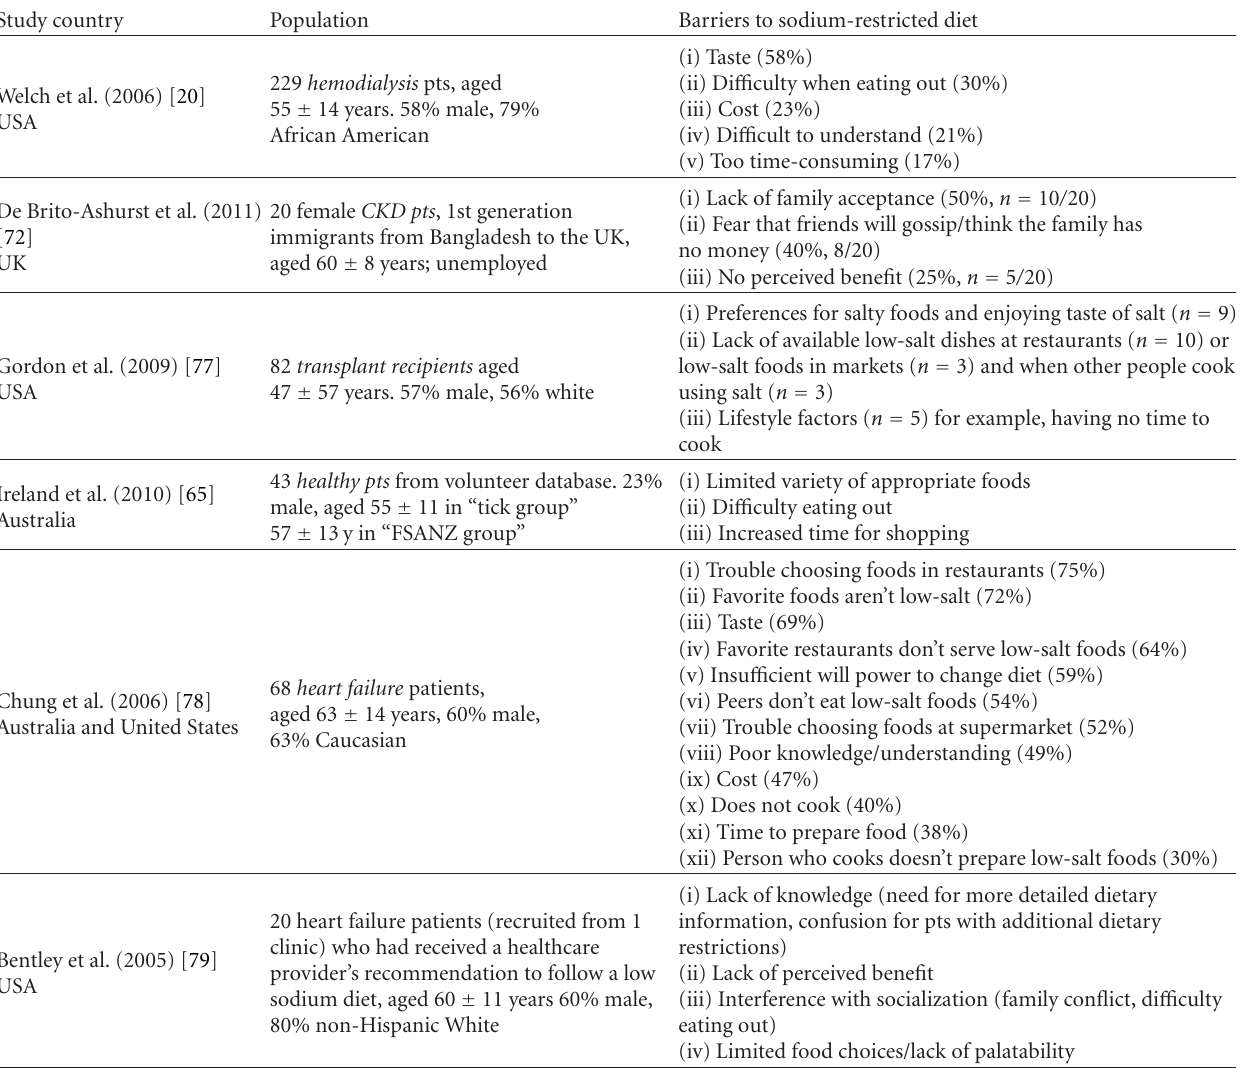
Table 3: Summary of studies investigating barriers to adhering to a sodium-restricted diet. Study